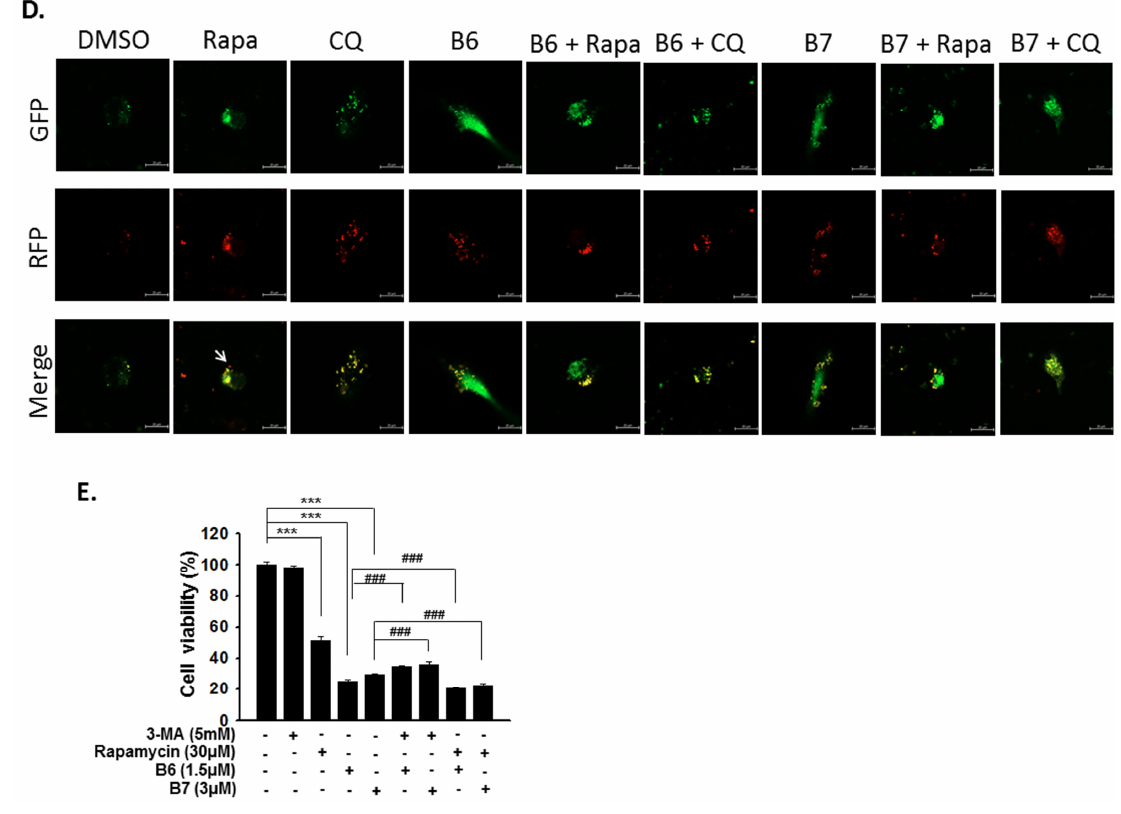
Figure 6. Autophagy regulation of B6 and B7 in non-small-cell lung cancer cells. ( A ) A549 and ( B ) H1435 cells were incubated with control medium or B6 and B7, and the expressions of LC3-I/LC3-II and p62 were observed using western blotting. ( C ) LC3-I/LC3-II and p62 were determined in A549 cells under B6 and B7 treatment with their time course. GAPDH was used as a loading control. Three independent experiments were conducted. ( D ) Autophagic flux determined in A549 cells under B6 and B7 treatment. A549 cells were transfected with pmRFP-EGFP-LC3 and were treated with B6 (1.5 µ M), B7 (3 µ M), rapamycin (30 µ M), and chloroquine (10 µ M) for 48 h. The autophagosome (yellow) and autolysosome (red; marked by arrow) puncta were determined under confocal microscopy. DMSO was used as a negative control. ( E ) The cellular viability of A549 cells was examined in the cells’ incubation with B6 or B7 or in combination with 3-MA or rapamycin after 48 h post treatment. 3-MA was an autophagic blocker, and rapamycin was used as an autophagic activator. *** and ### means p < 0.001.